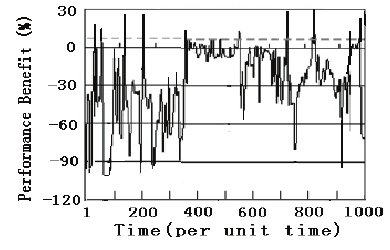
Fig. 5. Performance benefits due to service migration when service failures happened.